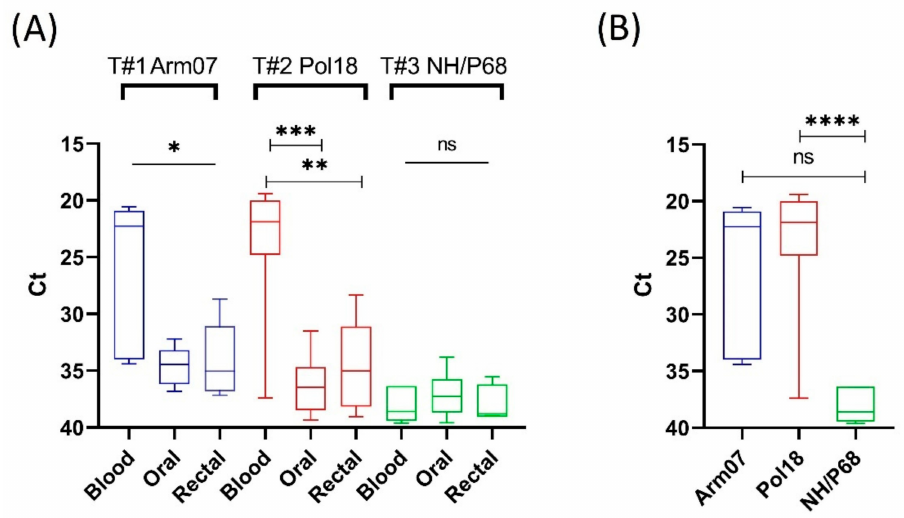
Figure 1. ( A ) Statistical analysis of mean Ct values in different matrices within respective trial groups. ( B ) Statistical analysis of mean Ct value recorded in blood between virulent and attenuated strains; * statistically significant (T1, blood vs. oral and rectal swabs, p = 0.0335 and p = 0.0450, respectively), ** statistically significant (T2, blood vs. rectal swabs, p = 0.0011), *** statistically significant (T2, blood vs. oral swabs, p < 0.0001), **** statistically significant (Pol18 vs. NH/P68, p = 0.004), ns—not significant. The boxes represent the 50% between the 25 and 75% quartiles. The line inside the box indicates the median. The top and bottom lines denote maximum and minimum